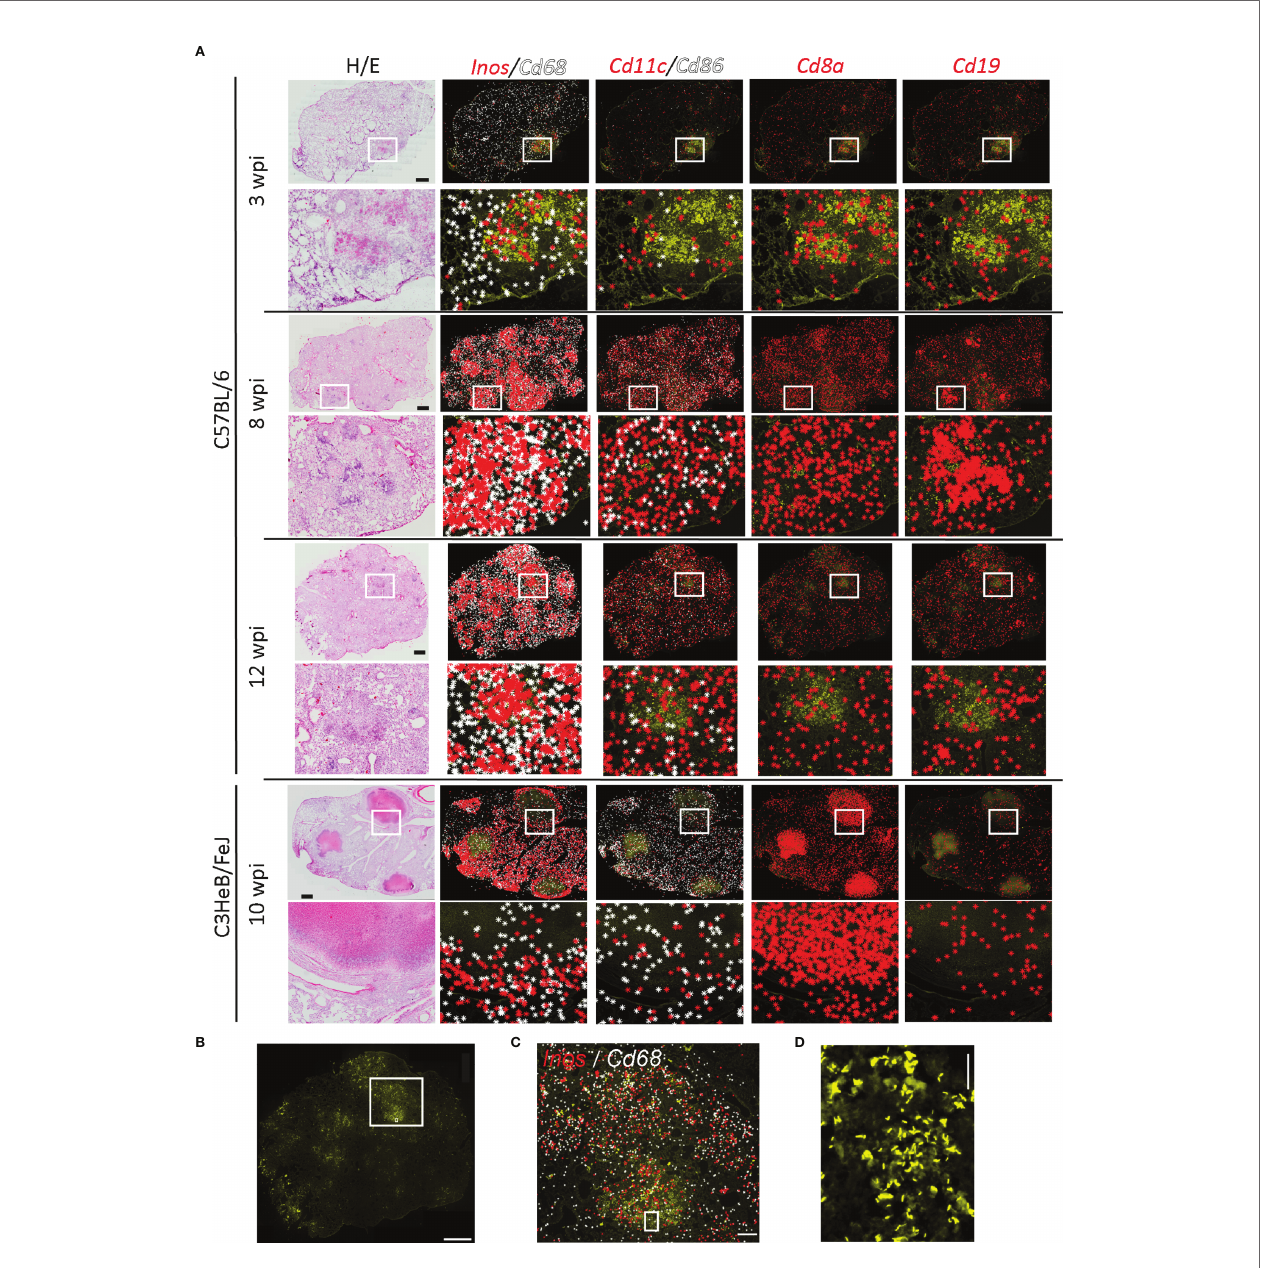
FIGURE 1 | Immune environments of Mycobacterium tuberculosis bacteria. Localization of immune transcripts in tuberculous lung granulomas. (A) Fixed lung tissue sections of C57BL/6 and C3HeB/FeJ mice at the indicated weeks post Mtb infection (wpi) were analyzed by ISS and stained for DAPI, Auramine – Rhodamine T (AR), and hematoxylin – eosin (HE). ISS signals for indicated transcripts were plotted on AR-stained image as background. One representative image out of the three sections per condition is displayed. Scale bar: 1,000 m m. (B) Image of AR staining of C57BL/6 lung section 12 wpi is displayed with a scale bar of 1,000 m m. Rectangular regions for zoom-ins are indicated. (C) Inos and Cd68 transcripts plotted on AR image (zoom-in of B). Scale bar: 200 m m. (D) Magni fi cation of AR image in B and C is shown for visualization of single bacteria and bacterial clumps. Scale bar: 20 m